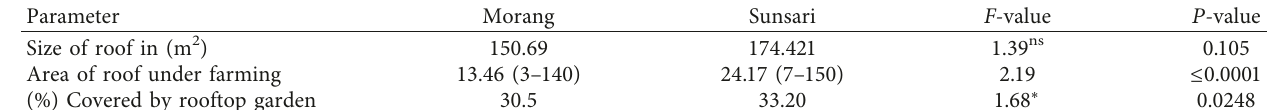
Table 6: Status of roof and garden based on study area.